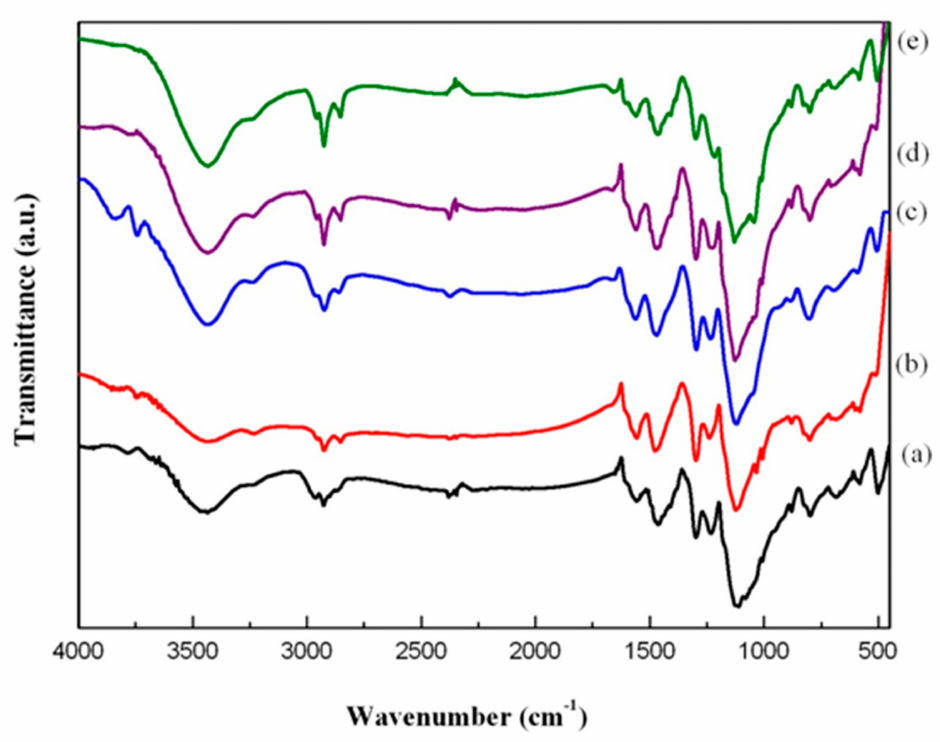
Figure 1. FTIR spectra of (a) pure PANDB and PANDB/ χ -Al 2 O 3 composites synthesized at AN/ χ - Al 2 O 3 weight ratios of (b) 0.5, (c) 1, (d) 1.5, and (e)